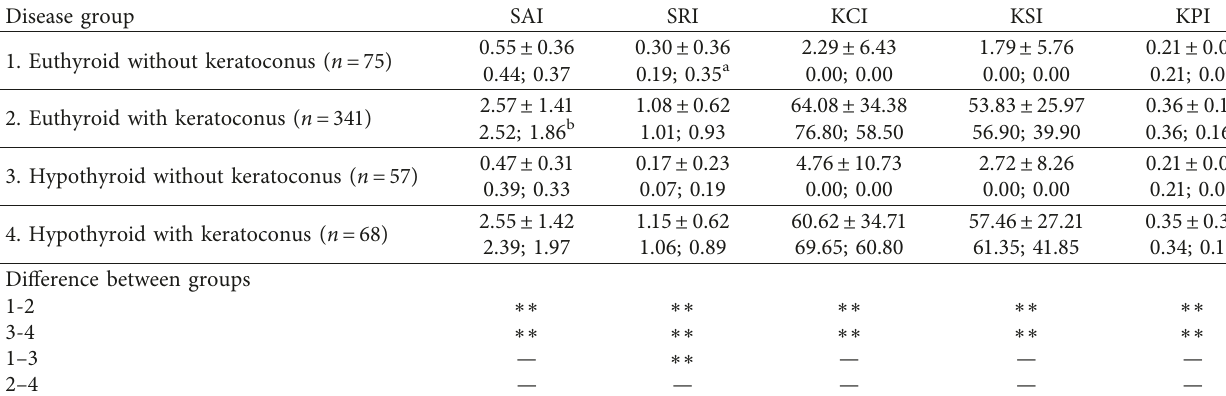
Table 2: Anterior corneal surface parameters measured with the TMS-5 in different disease groups. Disease group